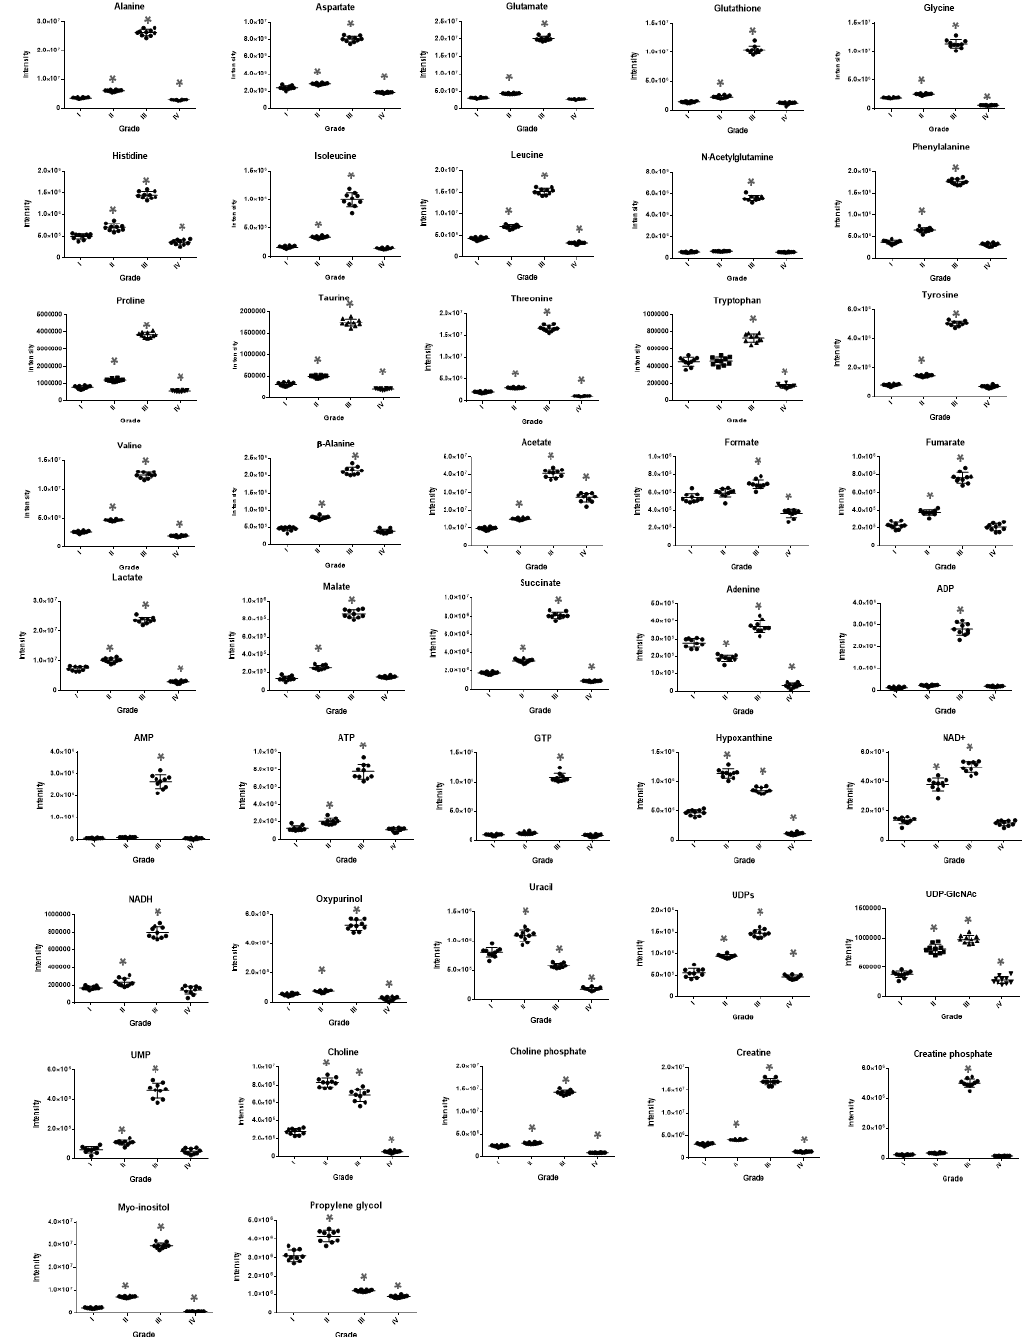
Figure 2. Boxplots of the 42 most significant metabolites, using ANOVA for the four-group urothelial bladder cancer (UBC) member comparisons. Myo-inositol, creatine phosphate, amino acids (e.g., histidine), organic acids (e.g., malate, succinate, and acetate), AXPs (AMP, ADP, and ATP), GTP, UMP, and oxypurinol follow the pattern of “metabolic inversion” that is being typified by their highly elevated contents in grade III (T24) group but reduced (restored) to the cell line-reference-like ones (RT4; grade I) in the grade IV (TCCSUP) UBC cell group. However, some metabolites are not subjected to the same pattern of grade-dependent deregulation (e.g., tryptophan, formate, uracil, adenine, propylene glycol, and choline). Remarkably, uracil and propylene glycol are presented with significant decreases during cellular transition from low to high grades (III and IV) of UBC